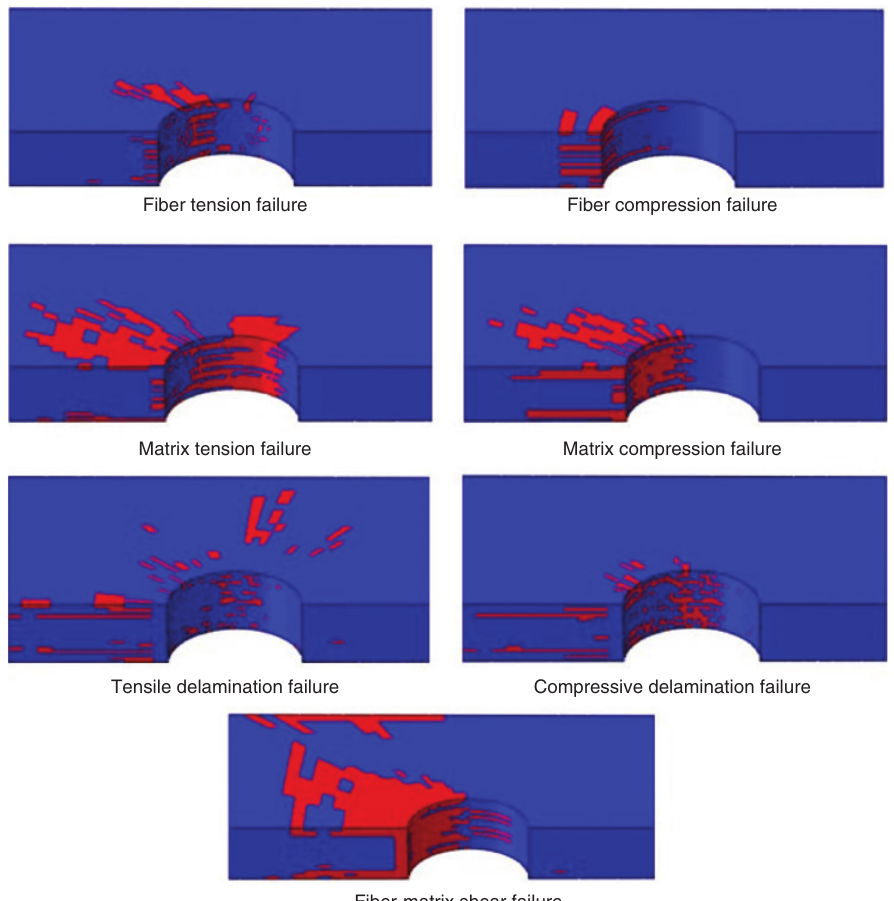
Figure 12: Failure modes simulated with Olmedo